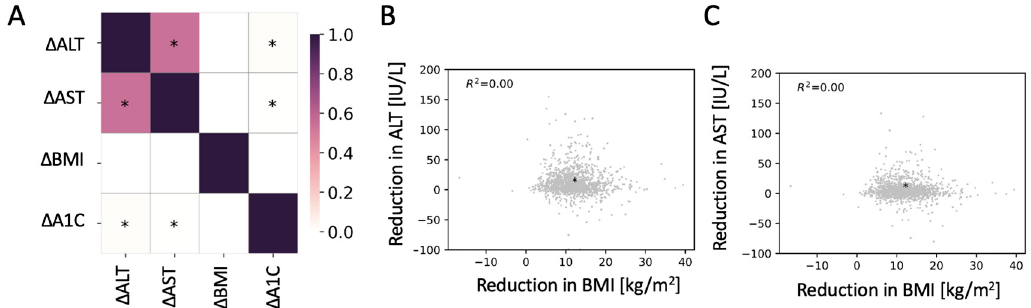
Figure 1. No correlation between changes in body mass index (BMI) with changes in the levels of alanine aminotransferase (ALT) or aspartate aminotransferase (AST). ( A ) Pearson correlation matrix for the changes in ALT, AST, BMI, and glycated hemoglobin (A1C) two years after bariatric surgery. * Significant correlation ( p < 0.05). ( B , C ) Scatter plot of the reduction in ALT ( B ) and AST ( C ) as a function of the reduction in BMI. * Median change. Table 2. Backwards elimination multivariate linear regression model for the change in ALT levels two years after bariatric surgery.